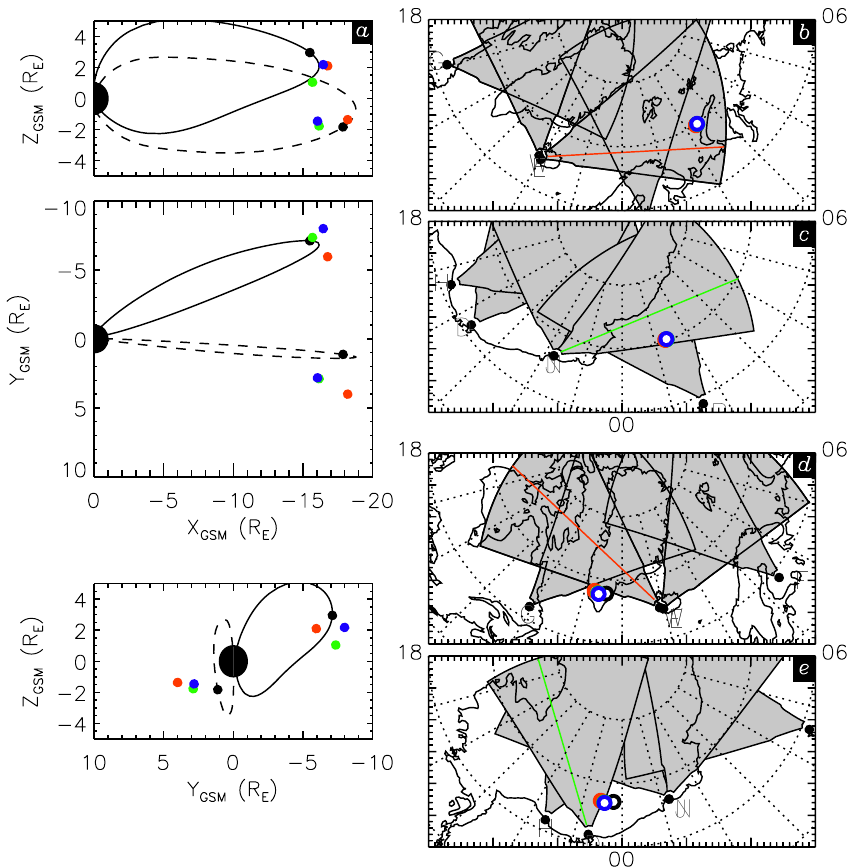
Fig. 1. (a) The location of the Cluster 1 spacecraft (black circle) in the x-z (top panel), x-y (middle panel) and y-z (bottom panel) GSM planes, superposed on its T-96 model field line (drawn solid for 22:05 UT on 14 August 2004 and dashed for 01:10 UT on 17 September 2005). Spacecraft 2–4 (red, green and blue circles, respectively) are also shown, but with their positions relative to Cluster 1 expanded (by a factor of 10 for the first interval and a factor of 2 for the second) for clarity. (b) Northern and (c) Southern Hemisphere SuperDARN radar fields-of-view drawn at 22:05 UT on a magnetic latitude-magnetic local time grid of the nightside ionosphere, with 18:00, 00:00 and 06:00 MLT marked. Iceland East-beam 12 and Syowa East-beam 10 are marked by the red and green lines, respectively. The T-96 mapped Cluster footpoints for 14 August 2004 are indicated by the coloured circles. (d–e) As (b–c), but for 01:10 UT on 17 September 2005, with Iceland West-beam 8 (red) and Sanae-beam 2 (green)